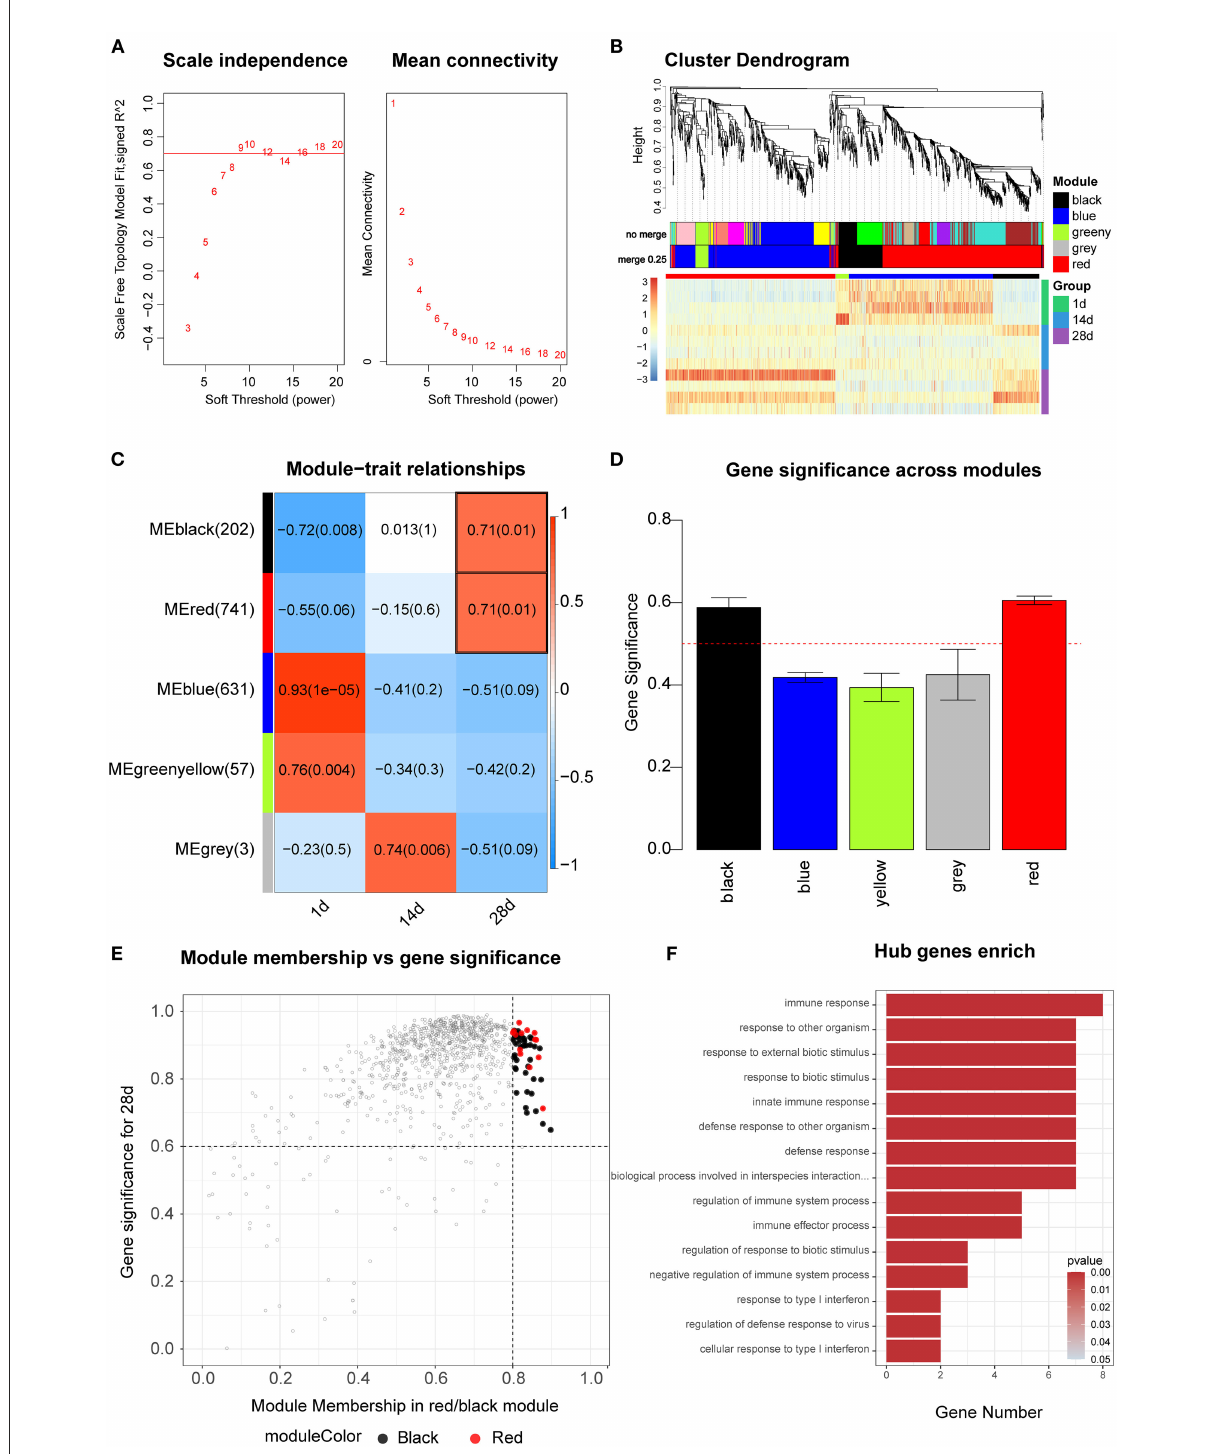
FIGURE5 WGCNA analysis. (A) Scale independence and mean connectivity analysis for various soft threshold powers. (B) Clustering dendrograms of mRNAs. Different colors indicate different co-expression modules. Heat map showing the expression profile of protein-coding genes. (C) Module–trait relationship. Each row represents a module eigengene, and each column represents a trait. Each cell includes the corresponding correlation and p -value. (D) Gene significance analysis for each of the 28 d modules. (E) Scatter plot of red and black modules. (F) GO enrichment analysis of the pathways of the red and black